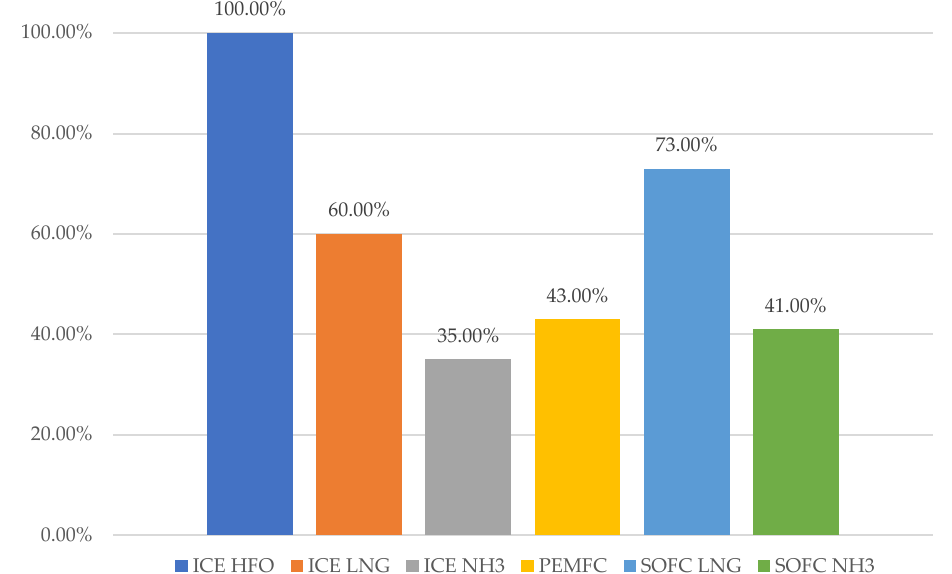
Figure 9. Comparison in percentage between autonomies for the different propulsion solutions.